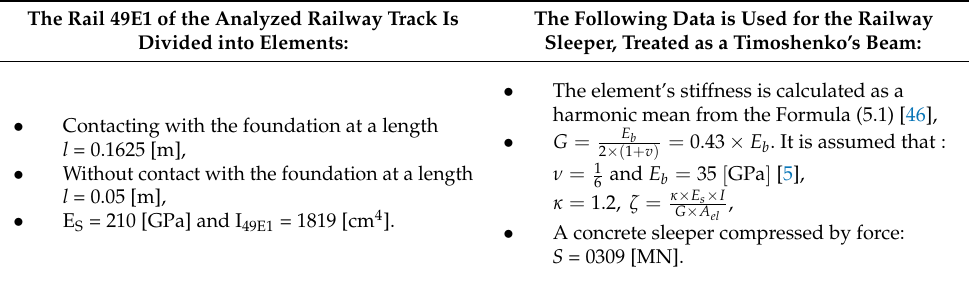
Table 2. The assumed additional parameters for calculations.